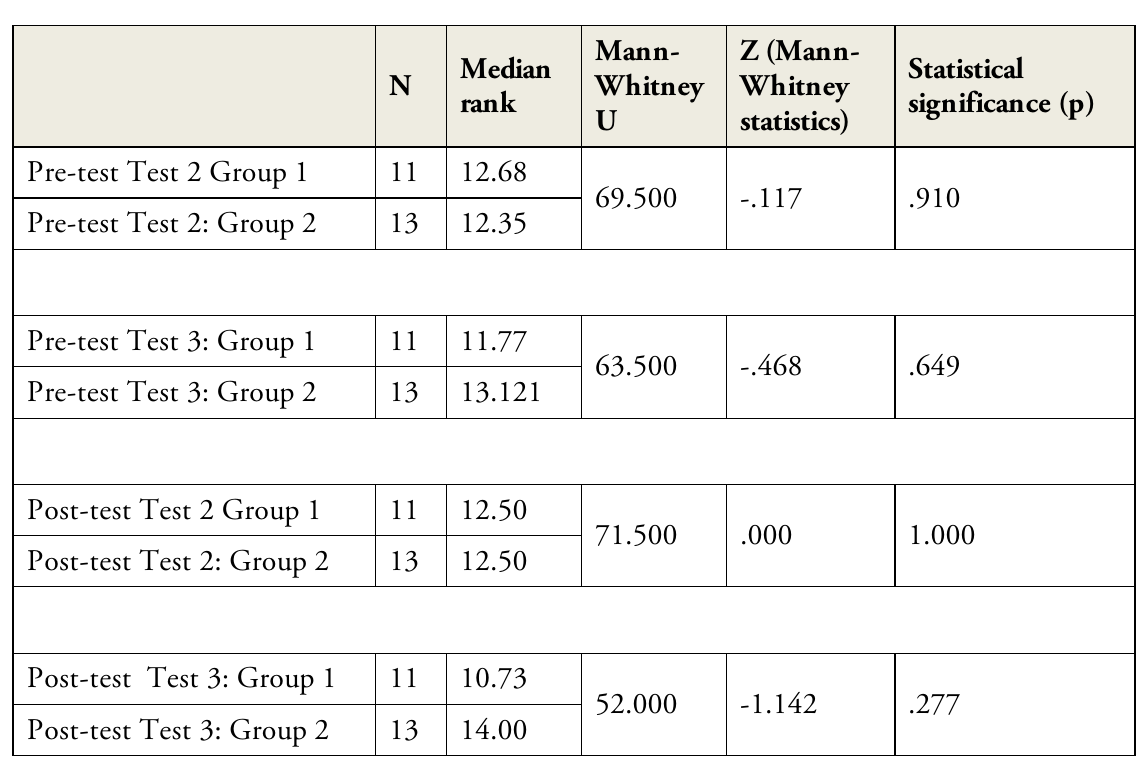
Table 2: Significance of differences between the pre- and post-test means when using the Mann-Whitney